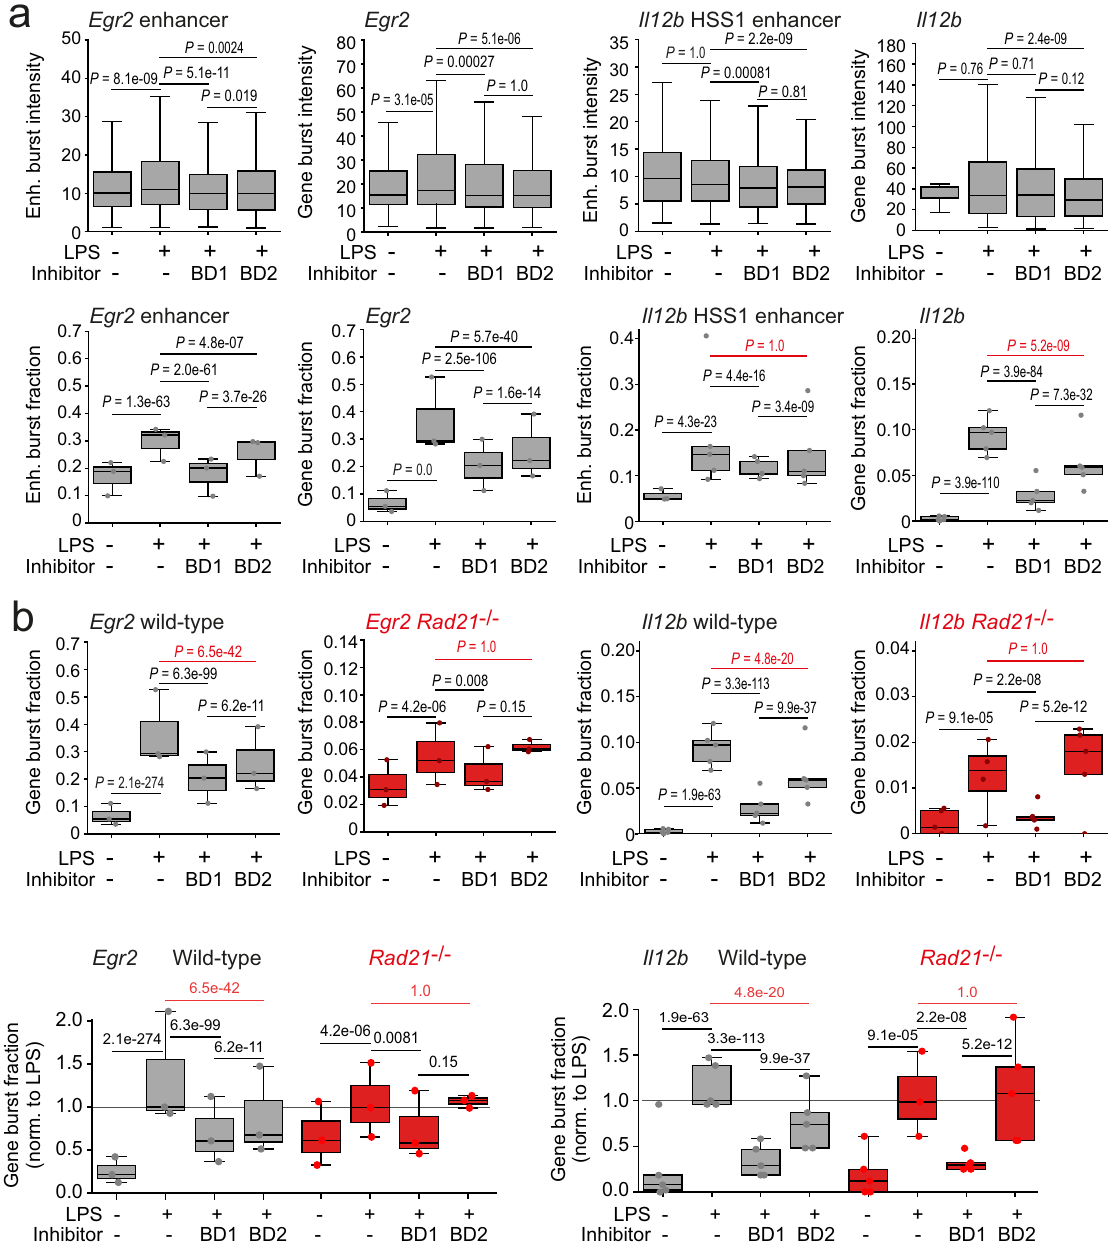
Fig. 9 Perturbations of cohesin and the second BET bromodomain BD2 have non-additive effects on burst fractions. a Transcriptional burst fractions of the Egr2 enhancer, Egr2 , the Il12b HSS enhancer and Il12b in wild-type macrophages 1 h after LPS activation in the presence of the BD1-selective